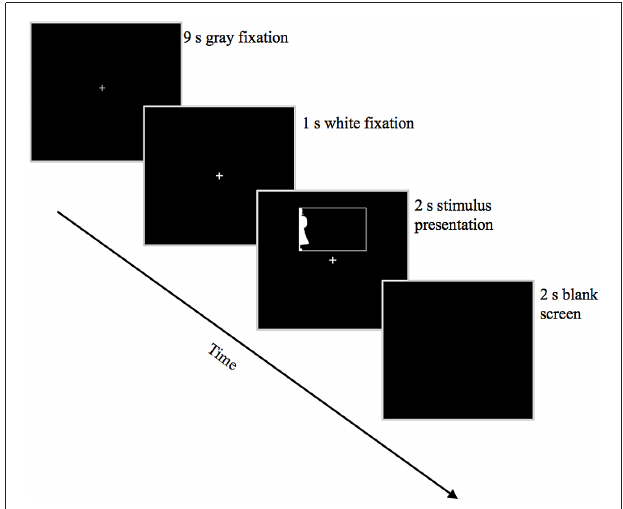
FIGURE 3 | Trial structure. Depicted here is an example trial showing a Familiar Configuration in the